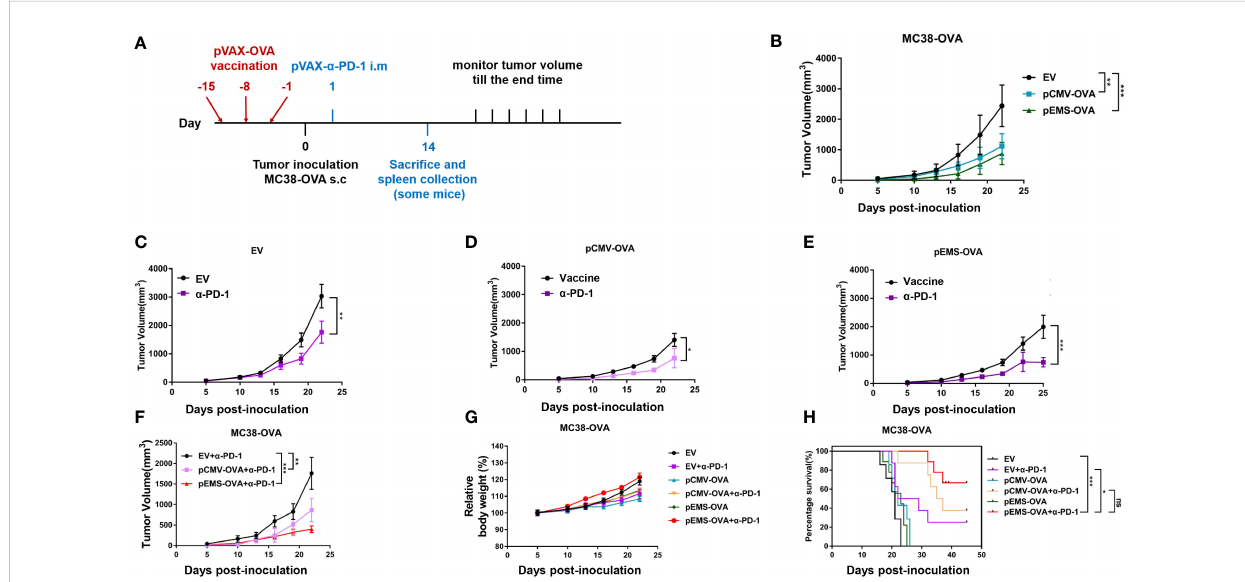
FIGURE 2 Anti-tumor activity of DNA vaccination and intramuscular gene transfer of PD-1 antibody combination in MC38-OVA model. (A) Schematic protocol of the tumor inoculation, DNA vaccination and pVAX- a -PD-1-Fc injection, and tumor measurement in MC38-OVA model. The DNA vaccines (pCMV-OVA or pEMS-OVA) were pre-intramuscularly electroporated 15 days, 8 days, and 1 day before 2 × 10 5 MC38-OVA tumor cells were subcutaneously injected into the right fl anks of C57BL/6 mice. pVAX- a -PD-1-Fc were intramuscularly electroporated on day 1. Thereafter, the tumor volume was monitored every 3 days until mice were sacri fi ced. (B) Tumor growth curves of three different vaccine groups. The tumor growth curves of the empty vector (C) , pCMV-OVA (D) , and pEMS-OVA (E) DNA vaccination combined with pVAX- a -PD-1-Fc groups. (F) Tumor growth curves of three kinds in the pVAX- a -PD-1-Fc group. Relative body weight change (G) and percentage of survival curve (H) of mice receiving six different treatments. The error bars represent the mean ± SEM; n = 6 per group. Statistical analysis was carried out using one-way ANOVA with Dunnett ’ s multiple comparisons test or a Student ’ s t -test. The log-rank (Mantel-Cox) test was used to calculate the signi fi cance of survival ( *p < 0.05, **p < 0.01, and ***p < 0.001). ANOVA, analysis of